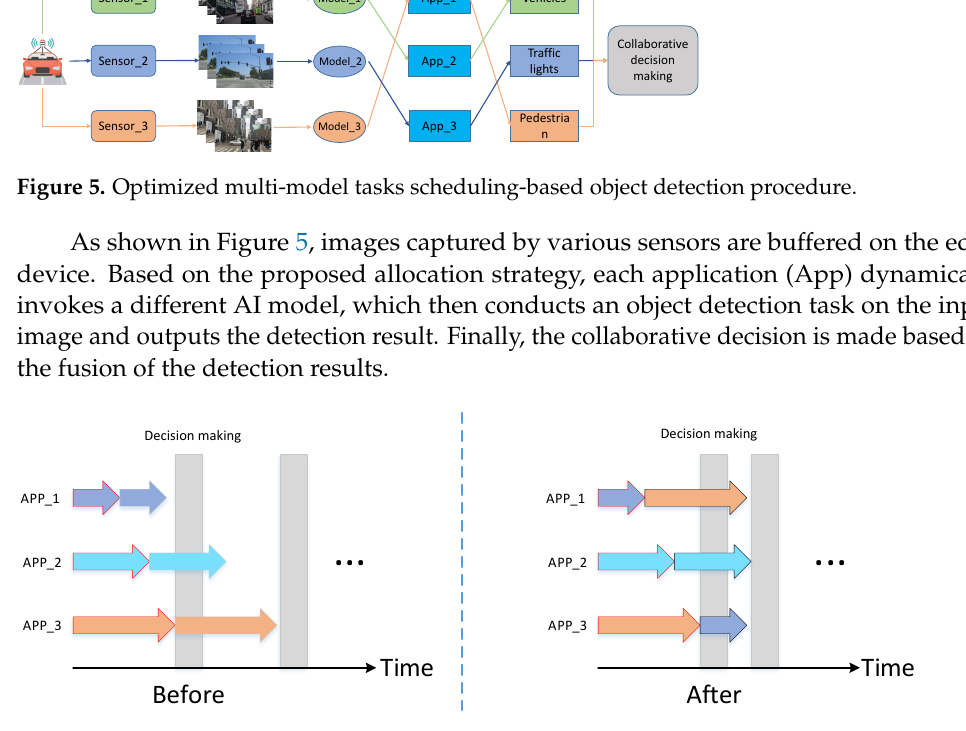
Figure 6. Comparison of the running time before and after the implementation of scheduling